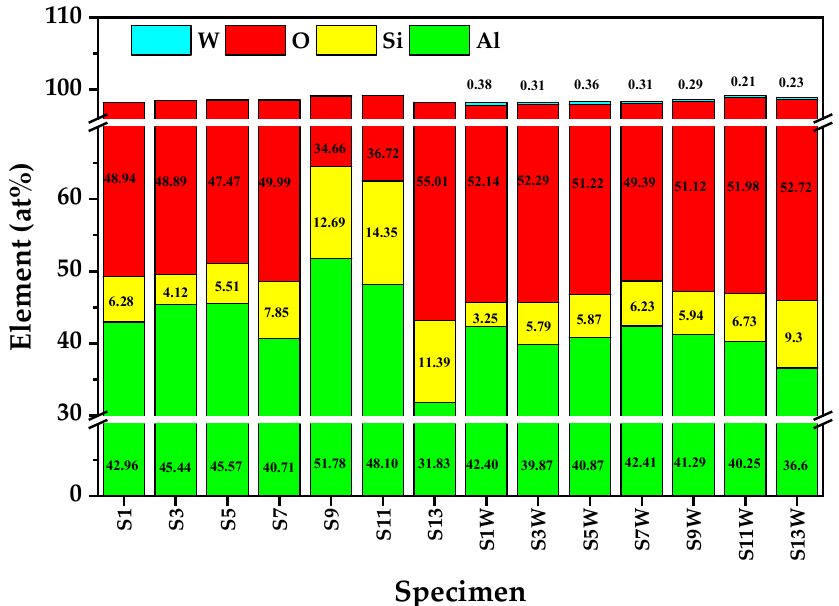
Figure 11. Elemental composition of cross-sections at the near-surface of coatings obtained using EDS analysis.